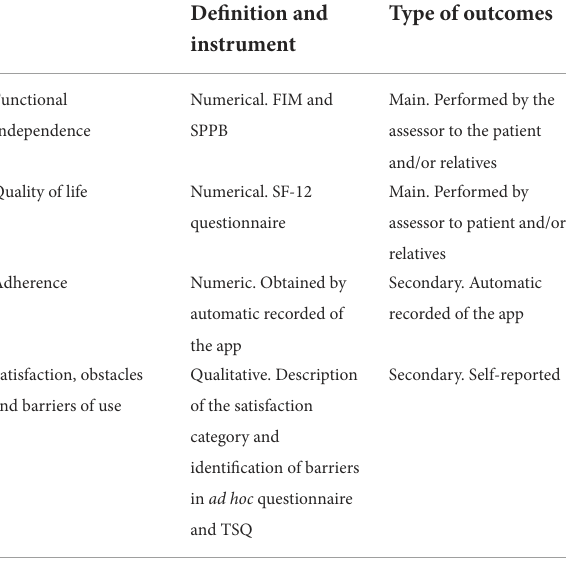
TABLE 1 Outcomes and measurement